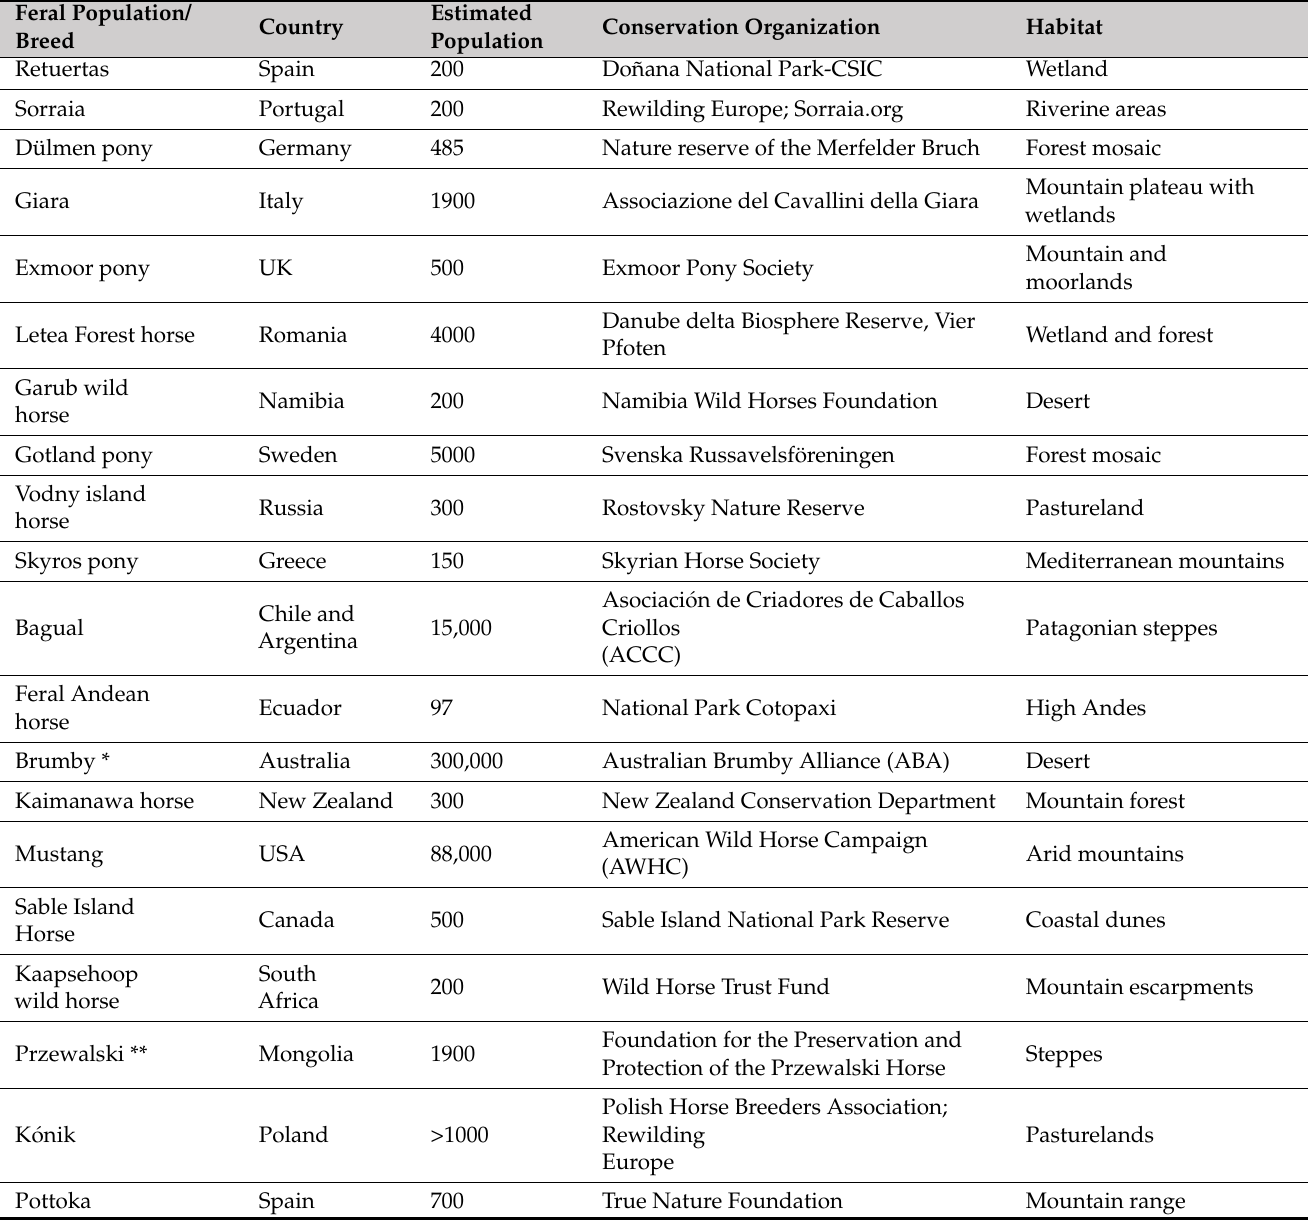
Table 2. Breeds or populations of feral horses selected as examples from around the world, and organizations in charge of their management. * Brumbies are a clear example of a feral population with a negative effect on ecosystems (see text). It is important to remark that no wild equids have inhabited Australia in the past. However, there are citizen entities concerned about horses. ** There is no consensus about the feral origin of Przewalski horse, but some authors consider it a truly wild species (for more details, see main